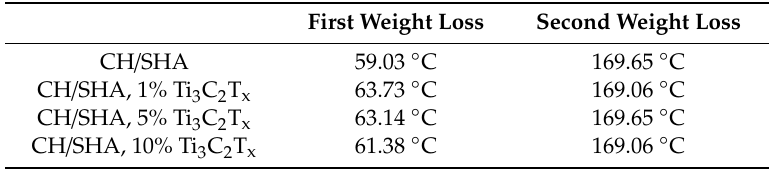
Table 1. TGA summary by first and second weight loss for the CH / SHA matrix